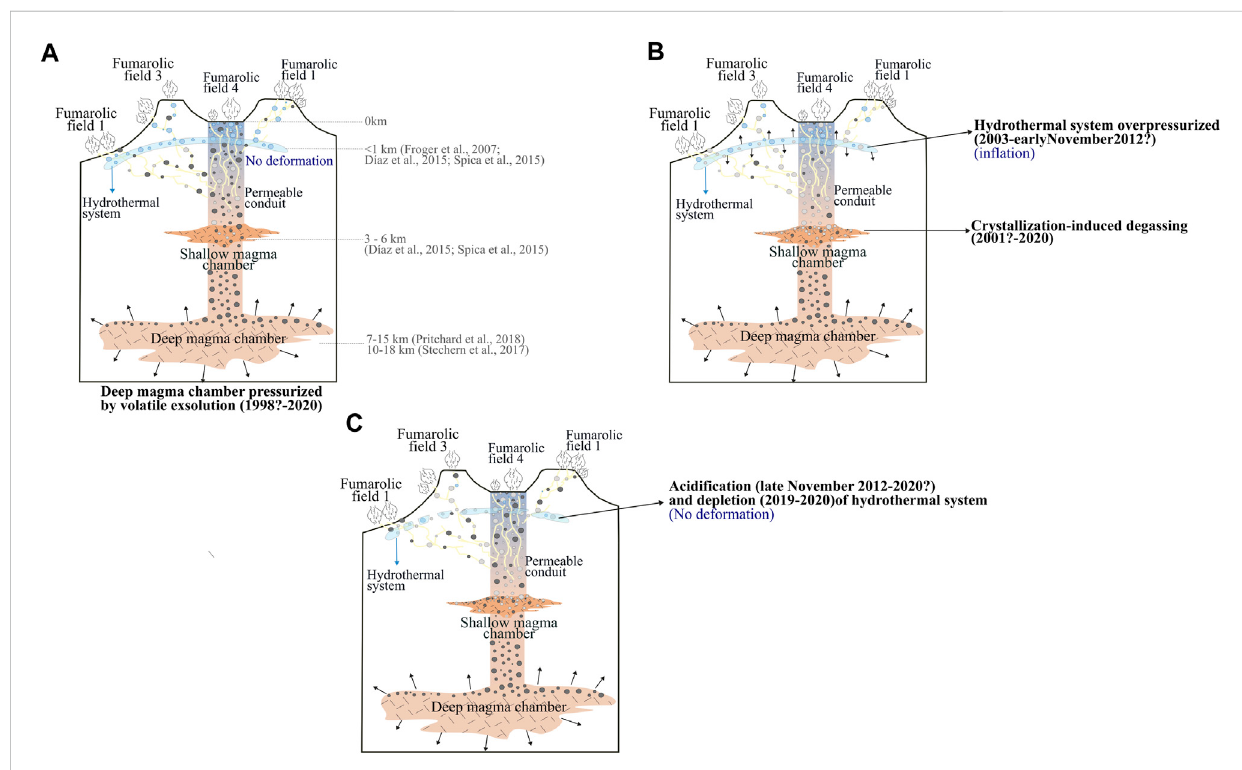
FIGURE 8 Conceptual sketches the sequence of mechanisms that explain the deformation and gas composition in the studied period. (A) Accumulation of deep-derived fl uids (1998 – 2011), (B) Crystallization induced degassing in the shallow magma chamber (2003 – 2019) and over-pressurization of the shallow hydrothermal system (2003 – 2009). (C) Acidi fi cation and drying of hydrothermal system (2003 – 2019). Dark grey bubbles represent volatiles exsolved from a deep magmatic source, light grey bubbles correspond to volatiles exsolved from a shallow magmatic source, and blue bubbles are volatiles from a boiling aquifer. Black arrows represent in fl ation of both magmatic and hydrothermal